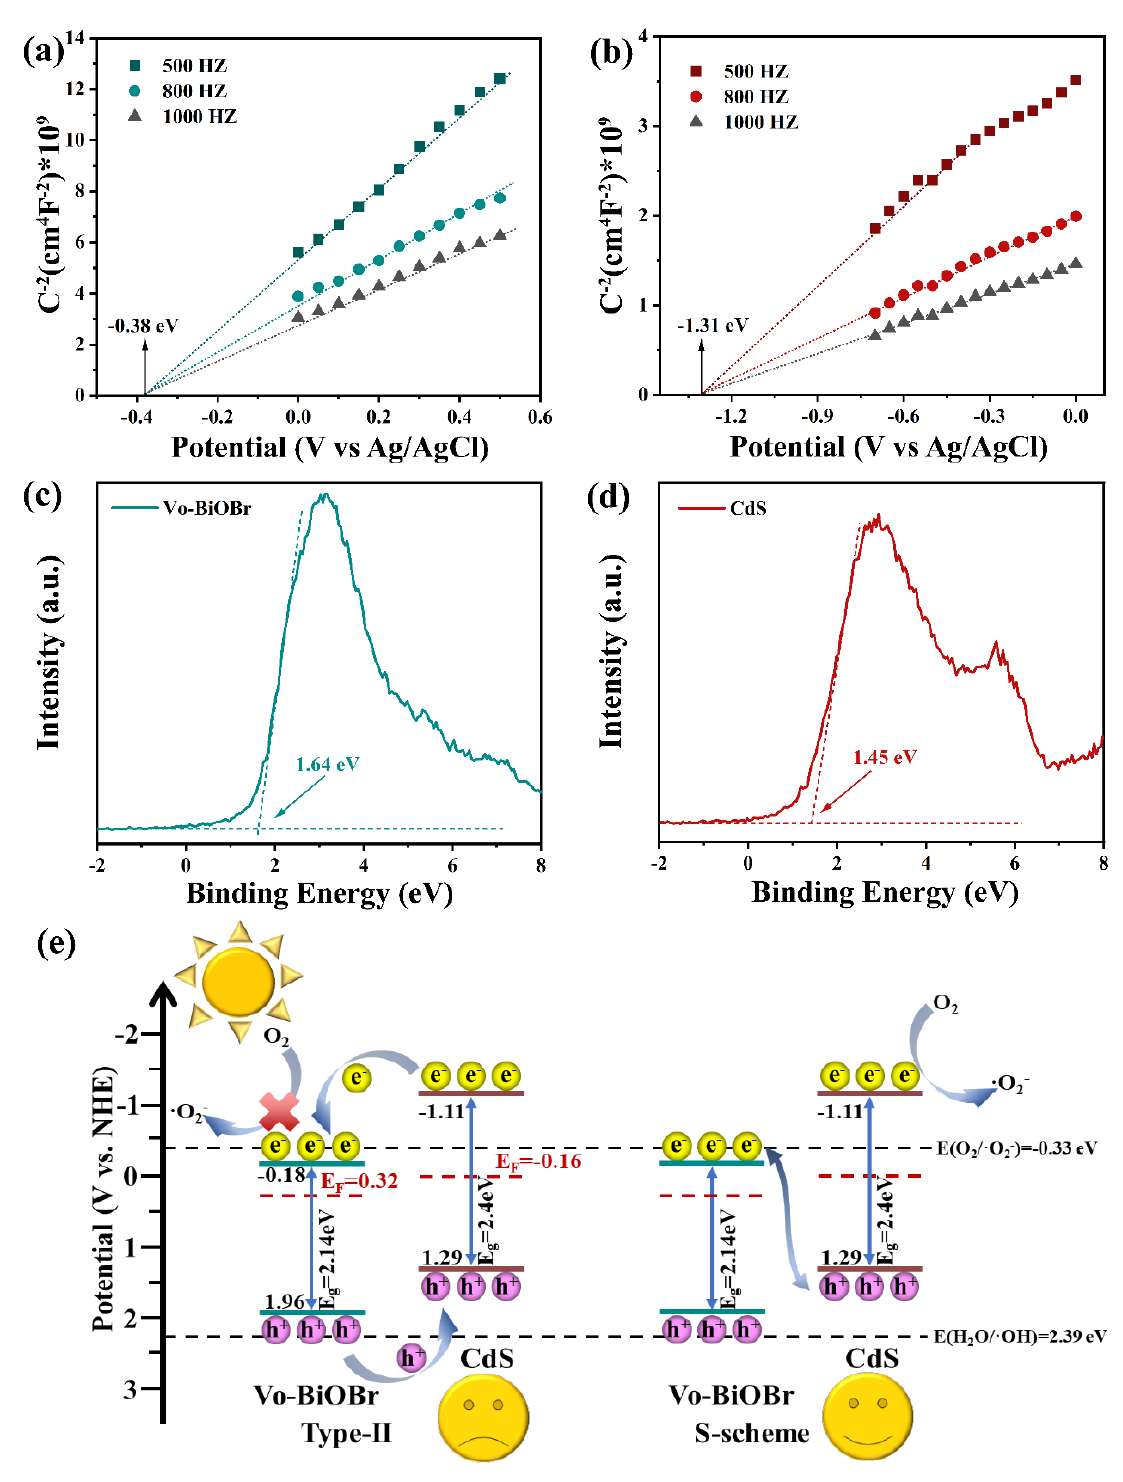
Figure 10. Mott–Schottky spectra of Vo-BiOBr ( a ), and CdS ( b ); XPS valance band spectra of Vo-BiOBr ( c ), and CdS ( d ); band structure of samples and photocatalytic mechanism ( e ).